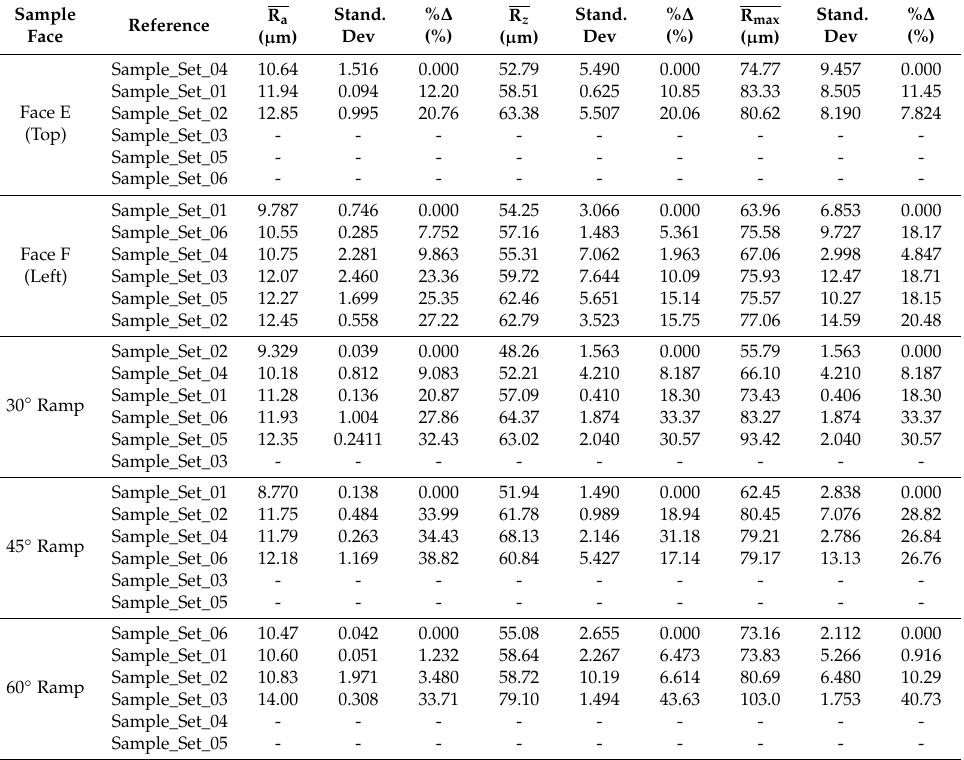
Table 8. Returned Roughness Values for Faces E and F, as well as 30 ◦ , 45 ◦ and 60 ◦ Angled Ramps. Sample